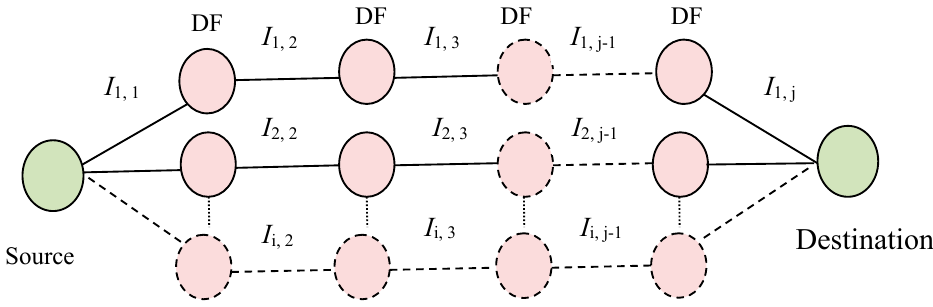
Figure 1. Mixed decode-and-forward (DF) relayed FSO communication system.